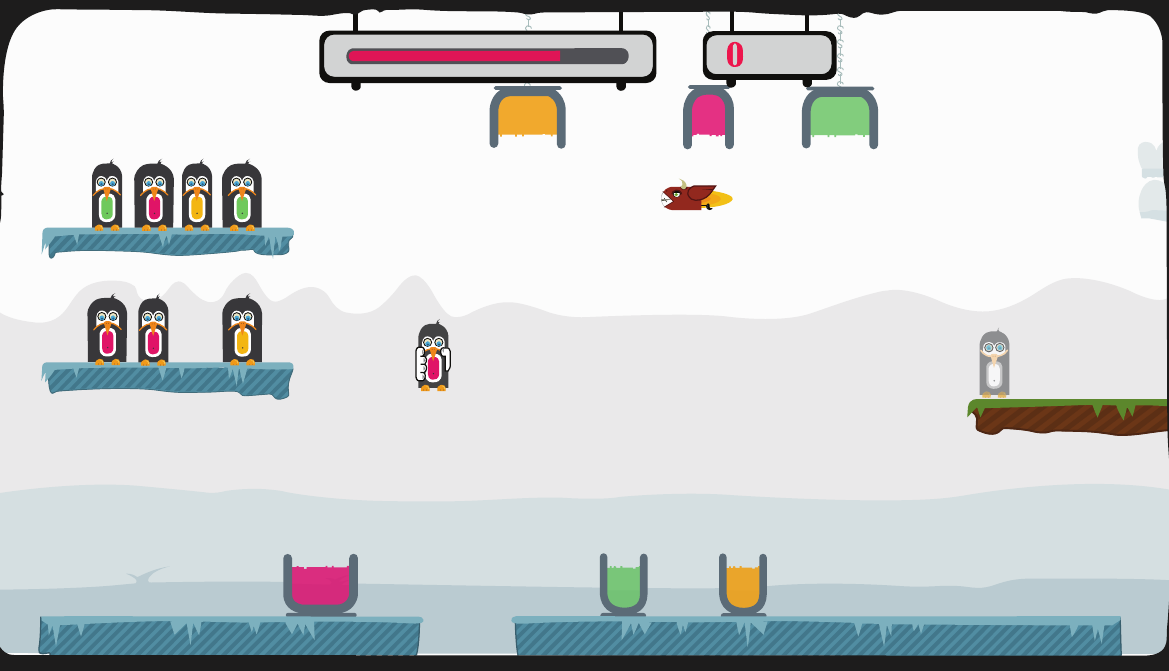
Figure 3: Experimental task: the penguin painting